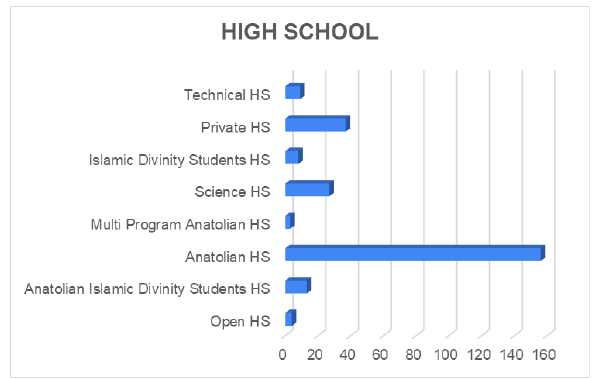
Figure 3. High School Graduation